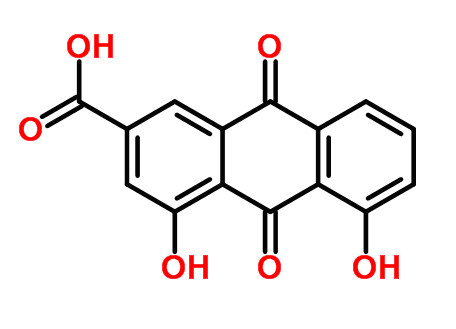
Chemical structure of rhein. ChemSpider ID: 9762; Systematic name: 4,5-Dihydroxy-9,10-dioxo-9,10-dihydro-2-anthracenecarboxylic acid; Molecular Formula: C15H8O6; Mass: 284.032074 Da.